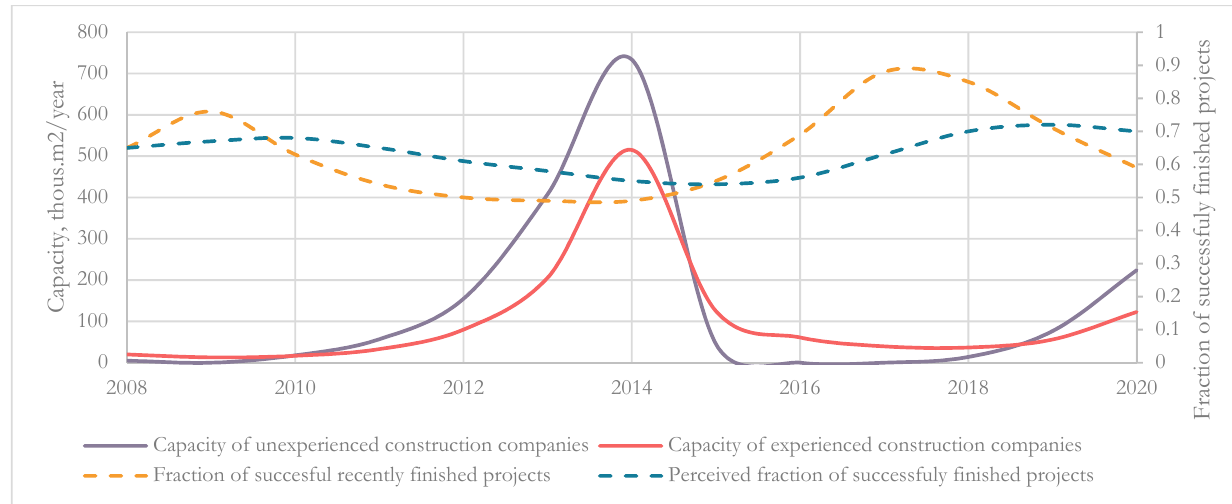
Figure 20. Simulated fraction of successfully completed projects and capacity of experienced and inexperienced construction companies with existing policy tools applied.